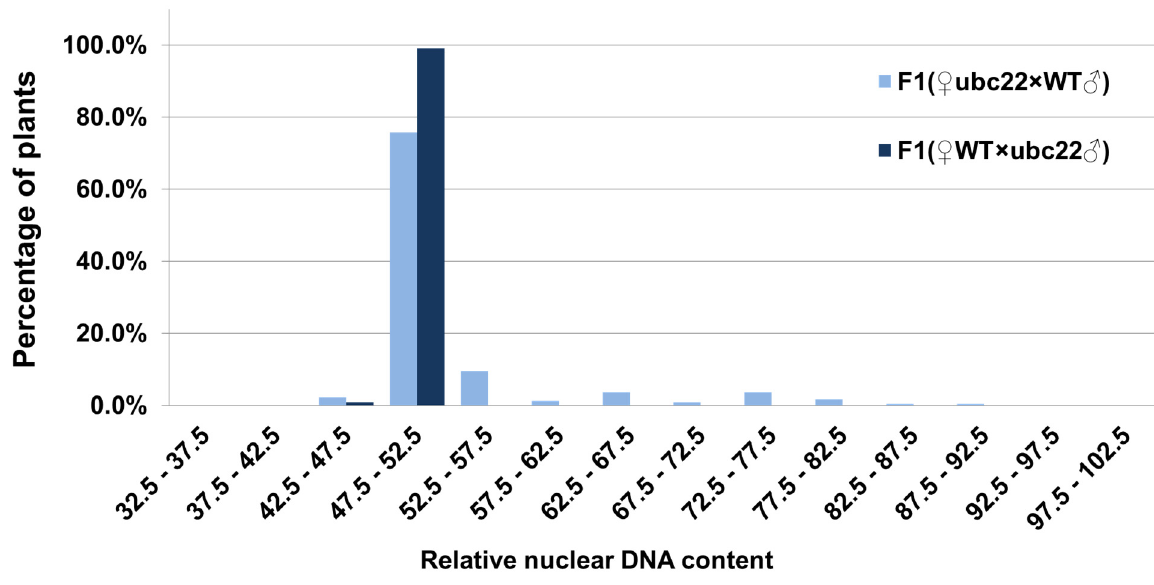
Figure 6. Relative nuclear DNA contents in F1 plants from the reciprocal crosses between the ubc22-1 mutant and WT. F1 plants produced from reciprocal crosses between the ubc22 mutant and WT were grown and their floral buds were used for flow cytometric analysis. Two hundred and twenty-one F1 plants using the ubc22 mutant as the maternal parent and one hundred F1 plants using the WT as the maternal parent were analyzed. In the floral bud tissues, there are two peaks, representing 2C and 4C nuclei (see Figure 5). For comparative analysis among different individuals, the relative value of the 4C peak was used. Parameters of the flow cytometry were set so that the average WT 4C peak value is about 50. The relative 4C values are grouped with increments of 5 s. The 4C peaks of WT samples were around 50 in the group of 47.5–52.5, while the 4C peak values of the plants with a nuclear DNA content of the triploid were in the group of 72.5–77.5.